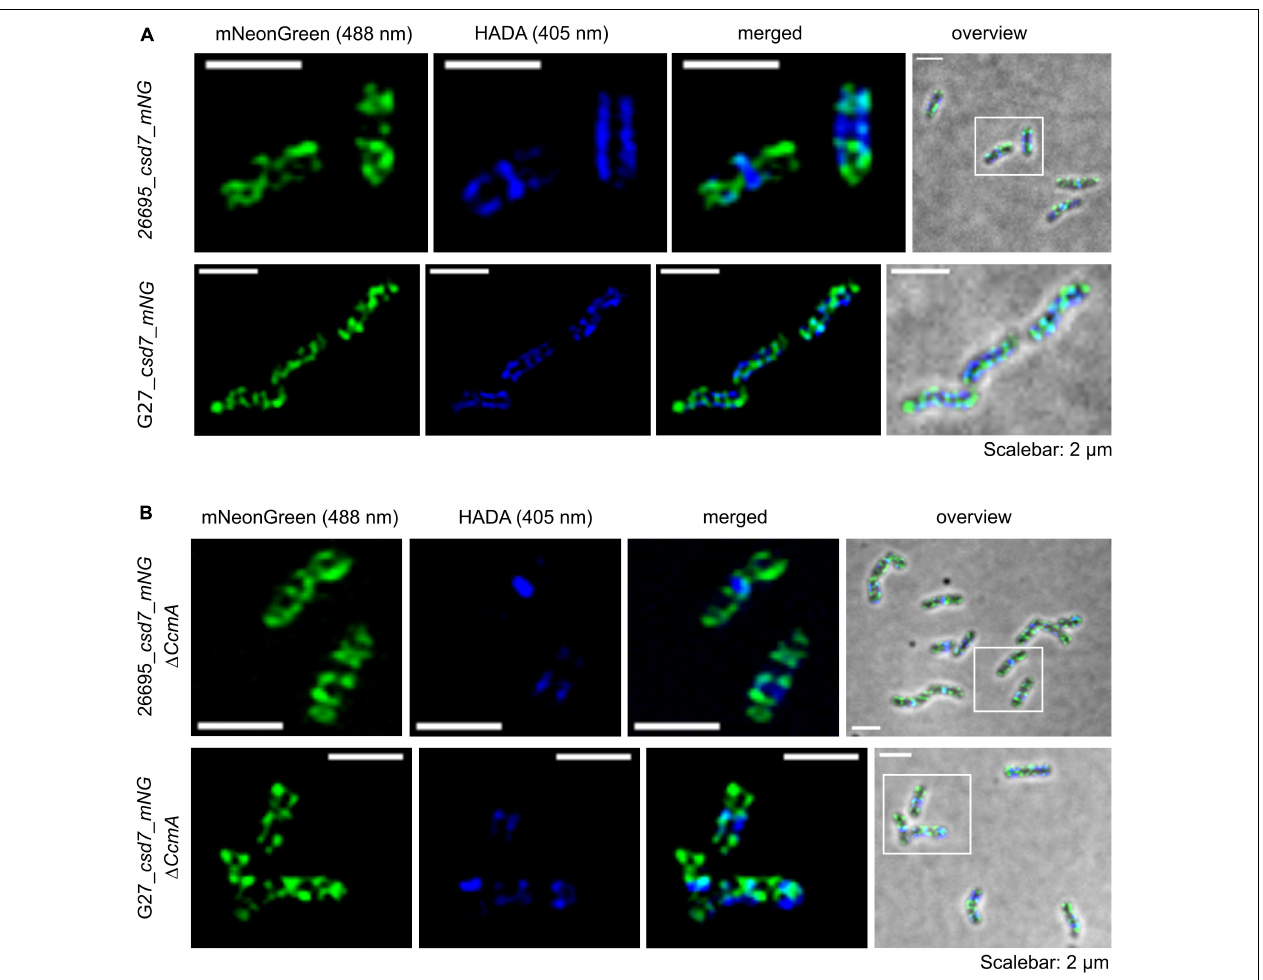
FIGURE 6 | Structured illumination microscopy of the Csd7_mNG fusion protein in H. pylori G27 and 26695 under wild-type conditions (A) and bactofilin deletion background (B) . Exemplary 26695 and G27 cells with Csd7_mNG (green) and newly incorporated peptidoglycan visualized by pulse labeling (20 min) with HADA (blue). Cells were acquired via Z-stack and projected by the average intensity. Scale = 2 µ m. The signal was located at the membrane with a predominant localization at the cell termini. The comparison revealed no altered signal localization pattern (microscope settings mNG: 488 nm laser, 10.0%, exp. time: 20 ms; HADA: 405 nm laser, 10.0%, exp. time: 50 ms; 3 rotations, EMCCD gain: